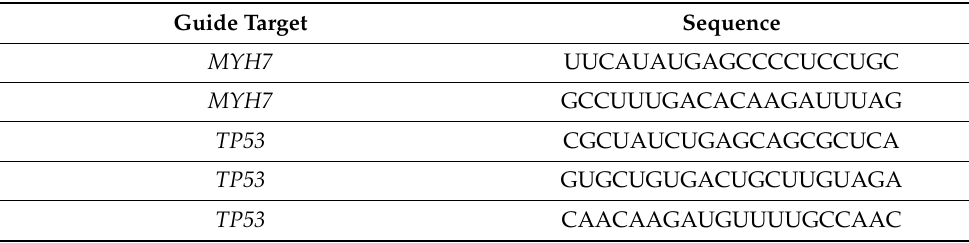
Table 2. sgRNA sequences for CRISPR/Cas9